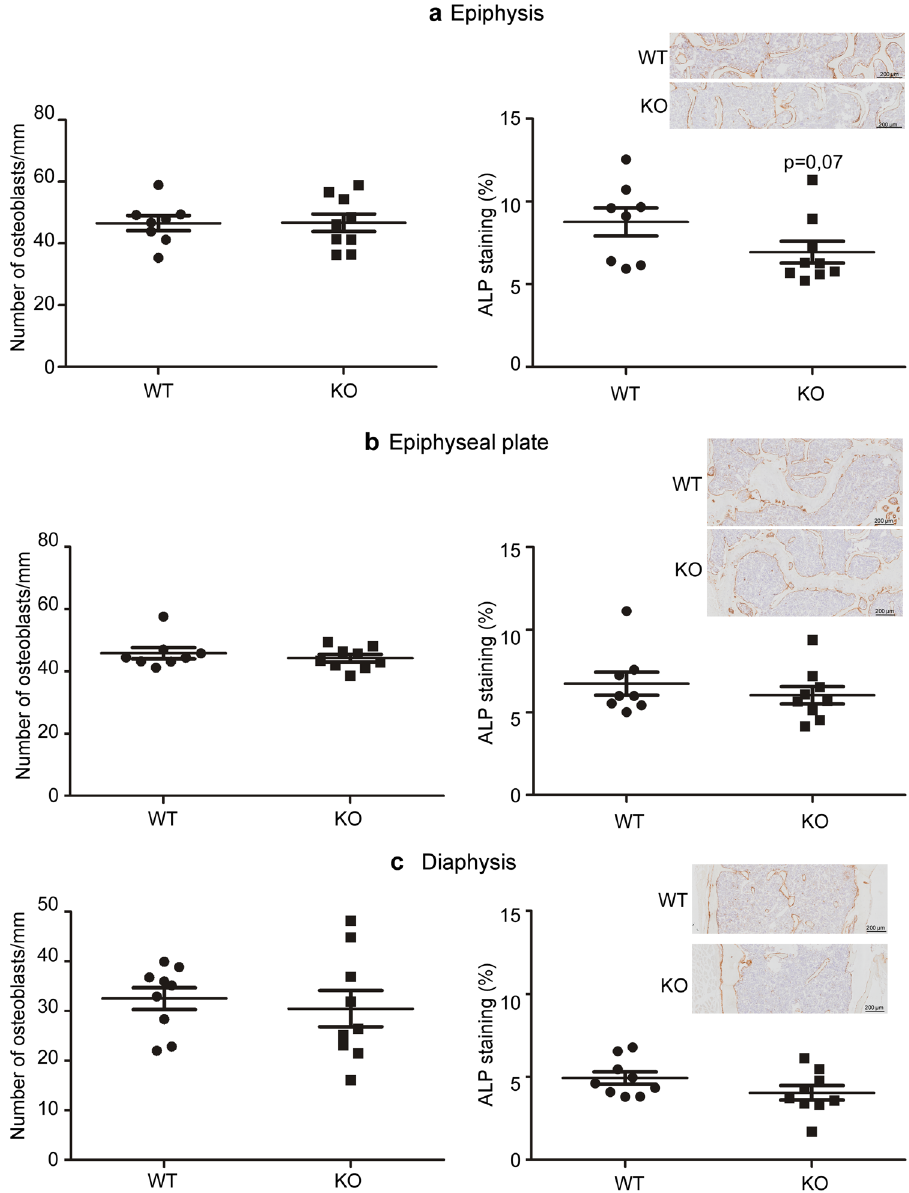
Figure 6. Osteoblast numbers are not modified in HYAL1 deficient femurs, but alkaline phosphatase (ALP) immunostaining is decreased in the epiphysis. ( a – c ) The number of osteoblasts per mm and the % of area positive for alkaline phosphatase were quantified on slices at the epiphysis, the epiphyseal plate, and the diaphysis (approximately at a 25–30% distance from the distal end) of 18-month-old mice (n ≥ 8 mice per group). N.B. Osteoblast numbers were counted in HES stained sections (see Fig. 5 for representative micrographies). The graphs show the means ± SEM. *p < 0.05 (two-tailed Mann–Whitney U